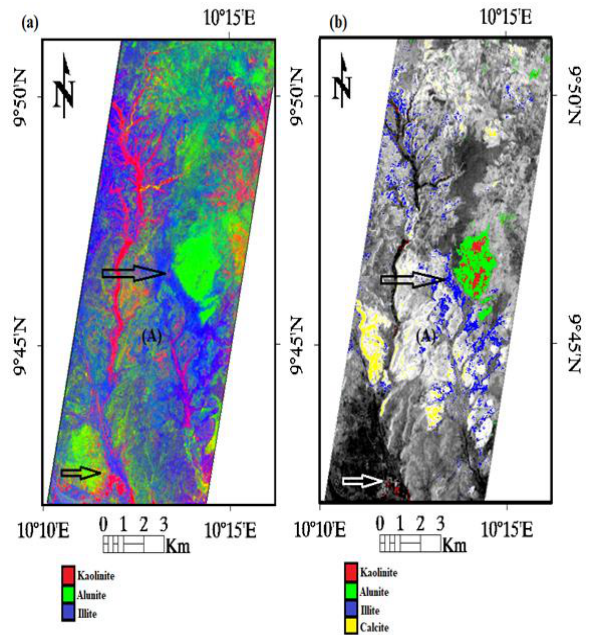
Figure 5 : (a) MF score RGB for selected endmembers (Hyperion) showing incoherent image with errors. (b) MTMF subpixel abundance image produced using mixture tuning